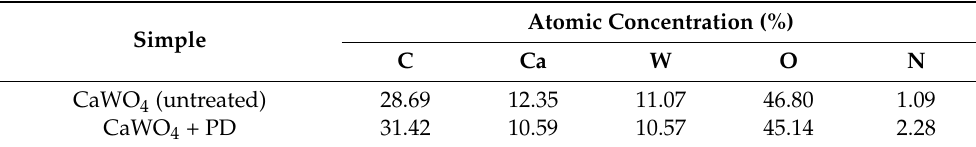
Figure 8. ( a ) Survey and high-resolution ( b ) Ca2p and ( c ) W2p XPS spectra recorded for scheelite pre- and post-PD processing. Table 1. Elemental composition of CaWO 4 with and without PD on its